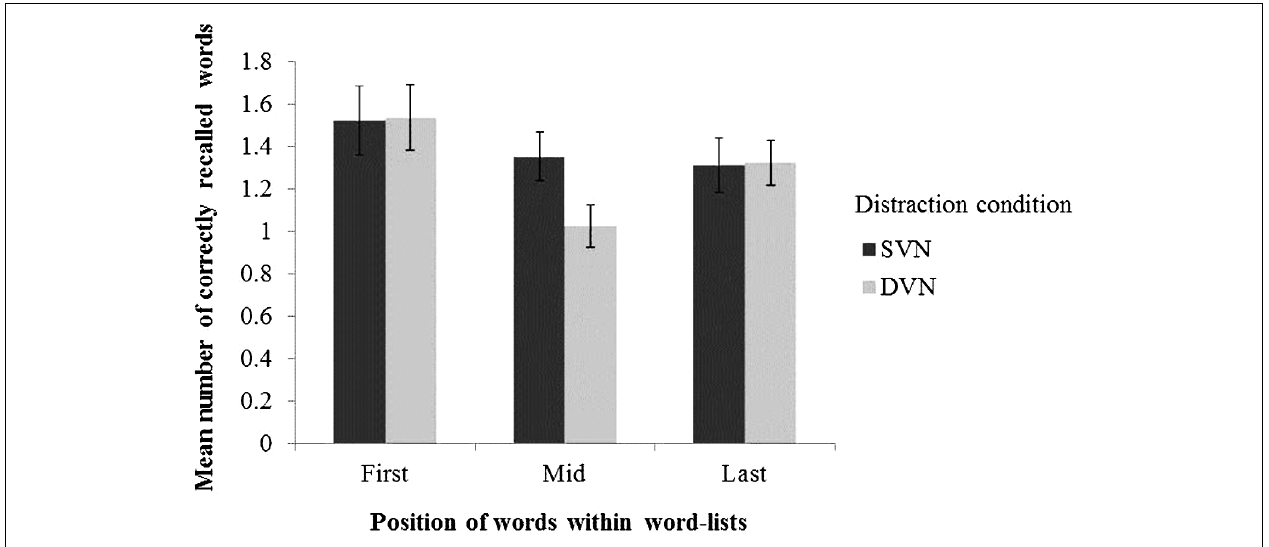
FIGURE 2 |The mean number of correctly recalled words from the First-, Mid-, and Last- five positions of each list. Error bars represent standard errors of the mean.